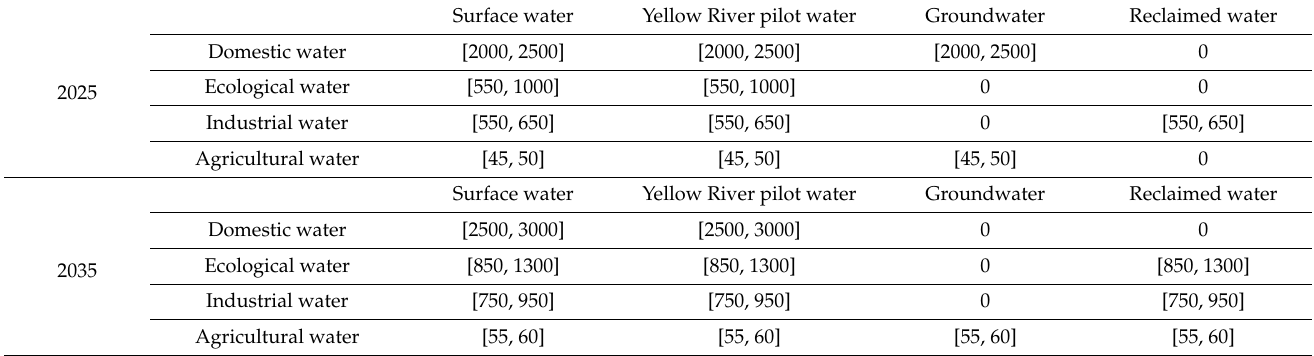
Table 3. Determination of the water use benefit coefficient (yuan/m 3